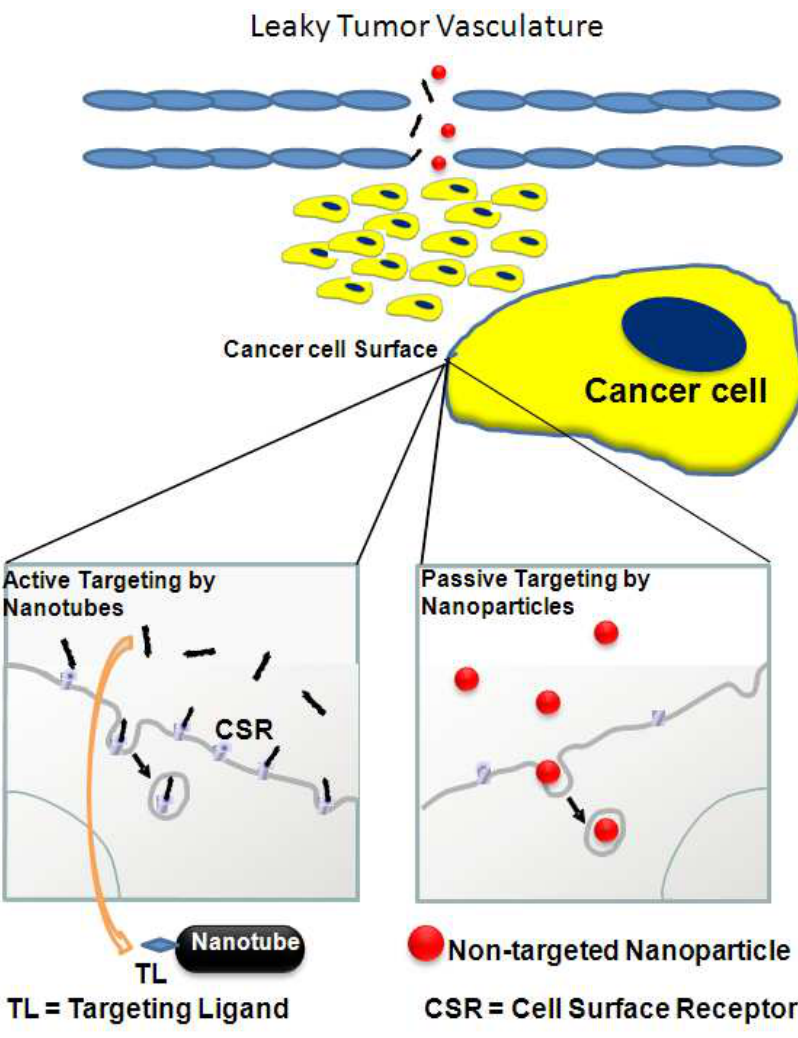
Figure 2. Active versus passive targeting in nanoparticle localization. Active Targeting ( left ): Ligand (antibody/peptide) driven localization, relying upon cancer surface receptor (CSR) mediated endocytosis. Passive Targeting ( right ): Enhanced permeability and retention (EPR) driven cellular localization, relying upon fluid